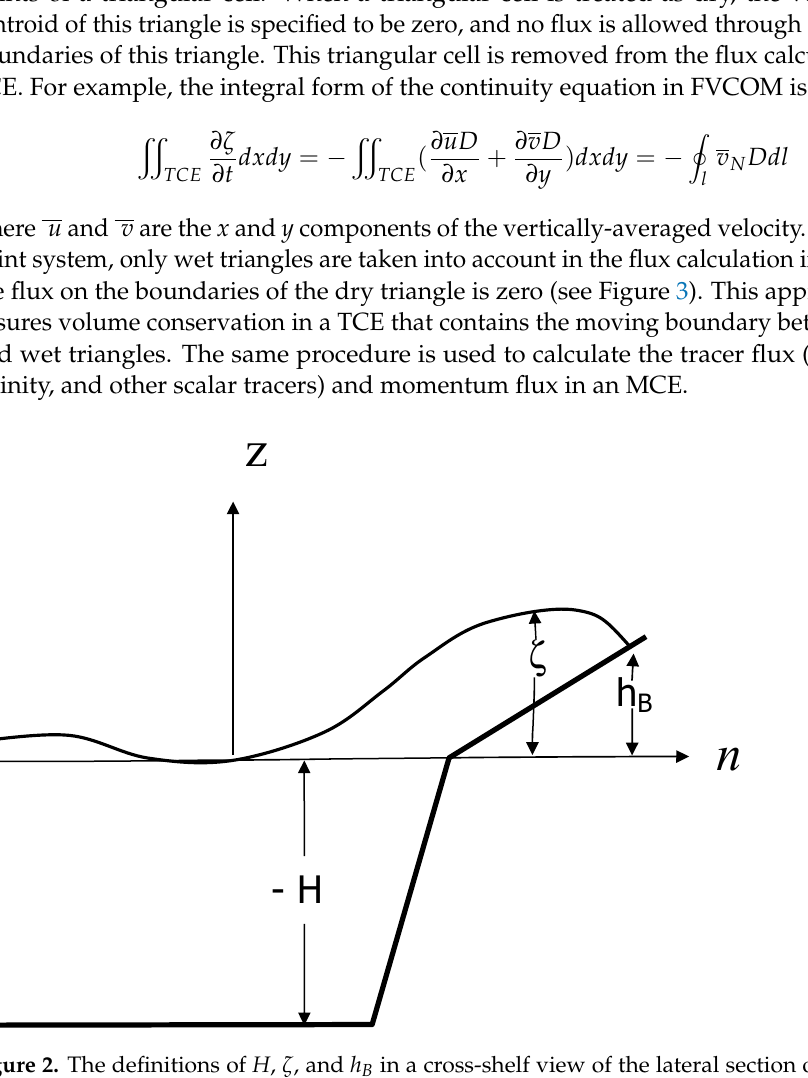
Figure 2. The definitions of H , ζ , and h B in a cross-shelf view of the lateral section of an idealized channel, including the intertidal zone.